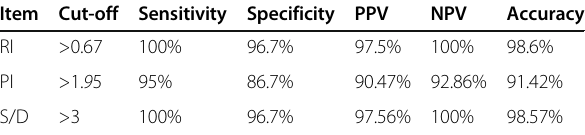
Table 4 The diagnostic performance of uterine arteries ’ RI, PI, and S/D ratios in discrimination of both the infertile and fertile groups Item Cut-off Sensitivity Specificity PPV